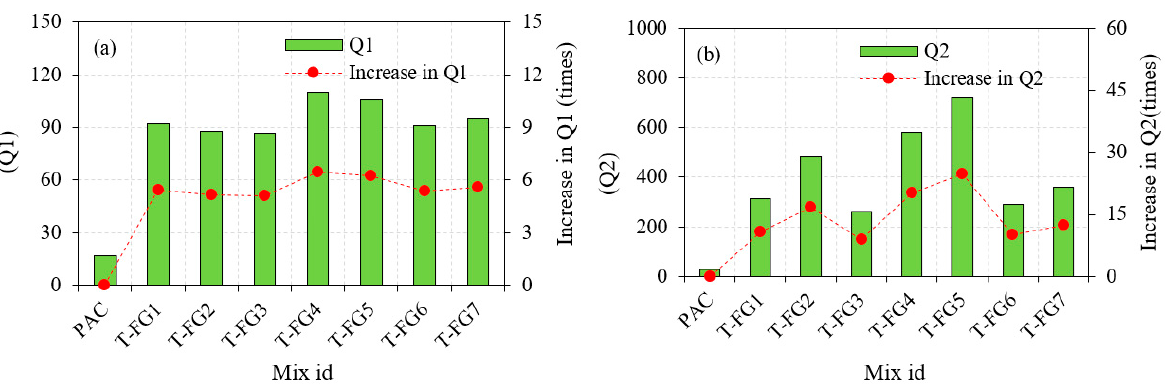
Figure 9. Impact strength of triple-layered specimen.